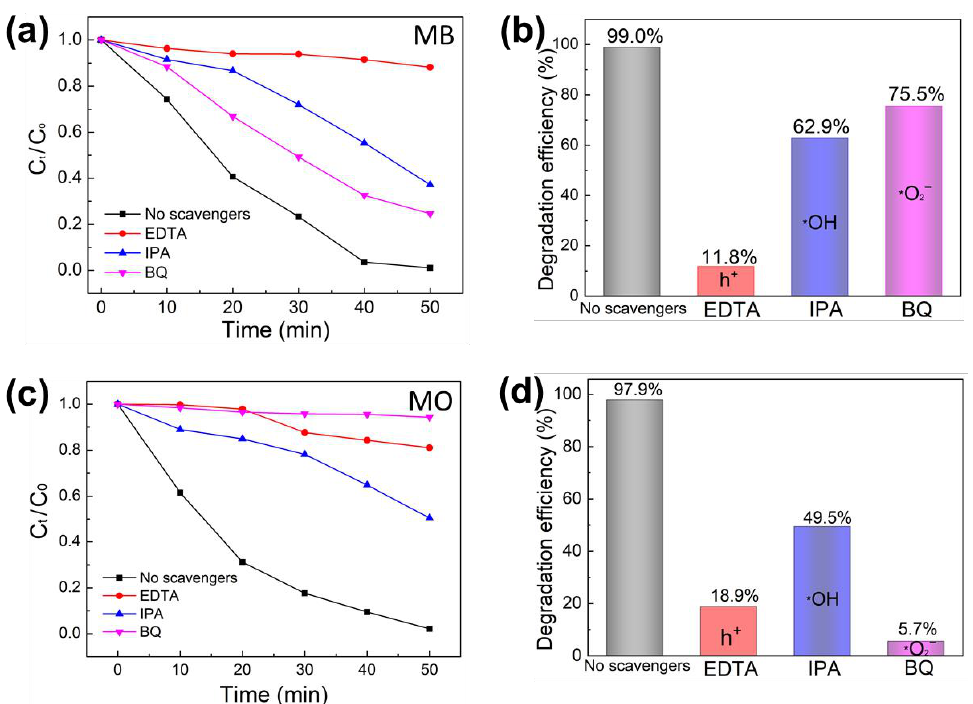
Figure 8. Effects of different scavengers on the photocatalytic degradation and degradation efficiency with ZnO/BNQD-4 nanocomposite for ( a , b ) MB and ( c , d ) MO.